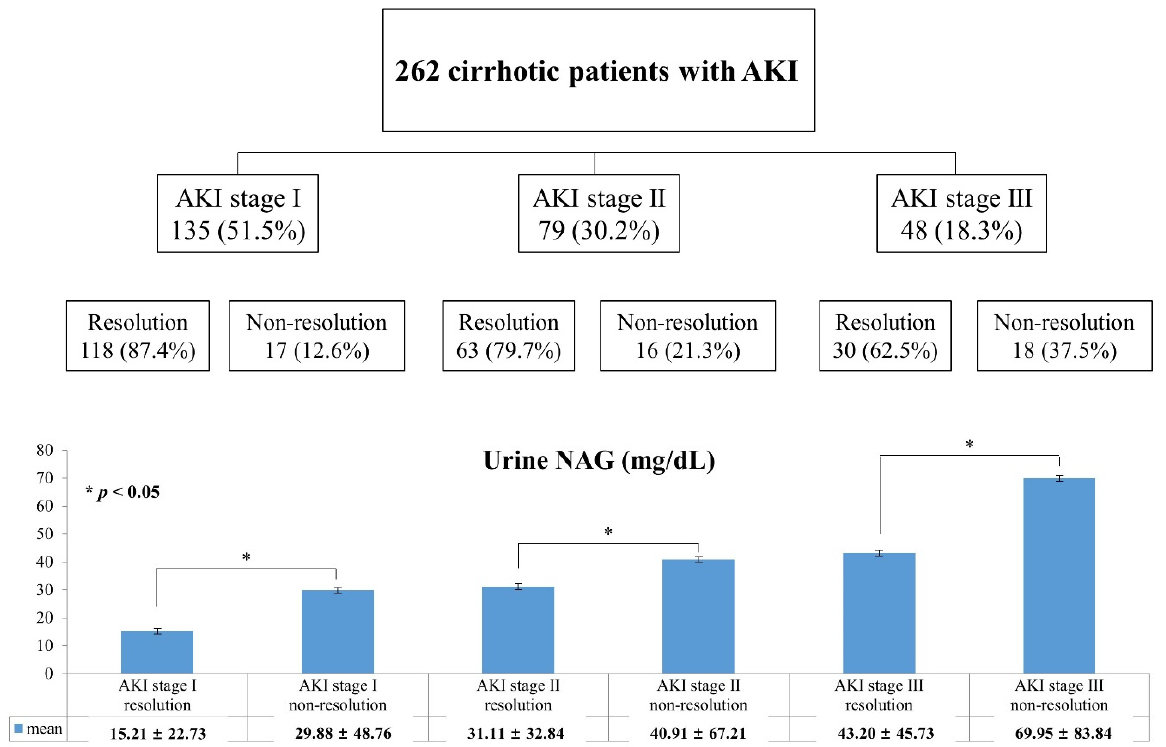
Figure 2. Flowchart of AKI status and urine NAG according to AKI regression. (* p < 0.05).